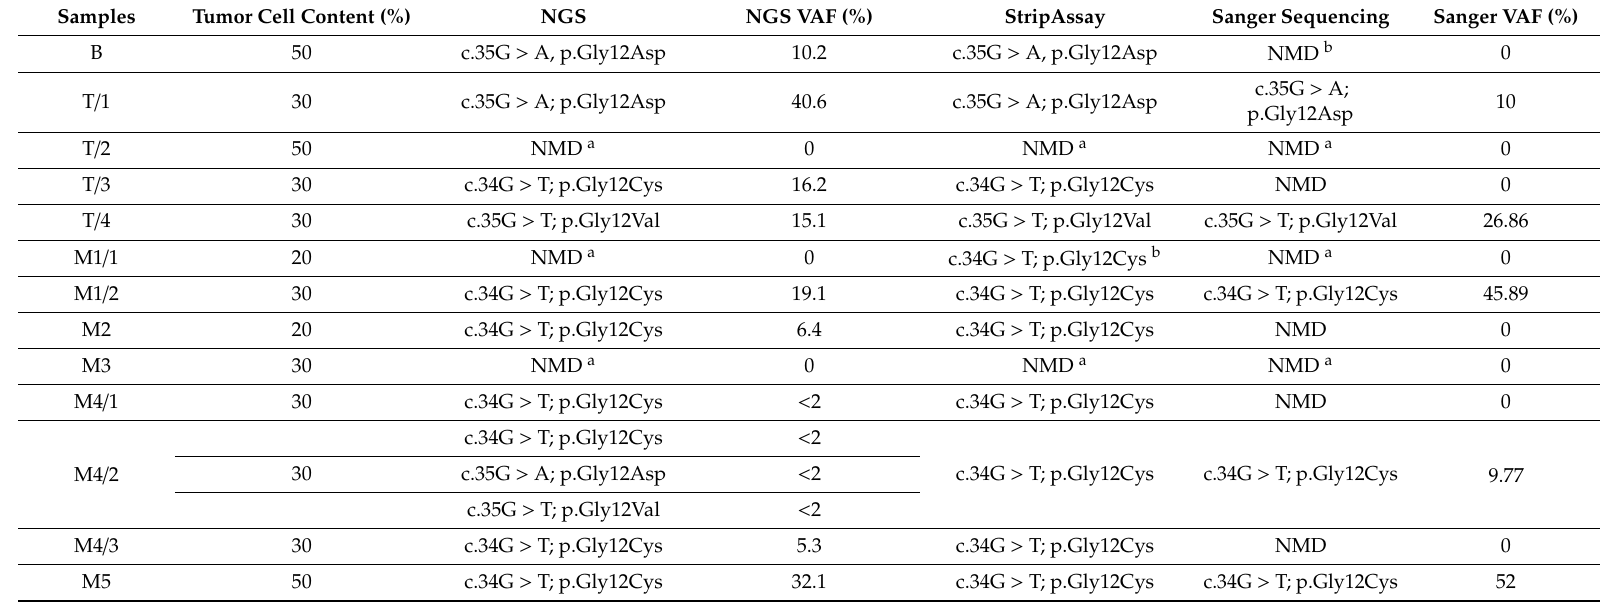
Table 2. KRAS gene variants detected by the TruSight Tumor 15 NGS panel, StripAssay and Sanger sequencing approaches from the primary tumors (T / 1-4) and metastatic tumors (M1-5) throughout the course of the